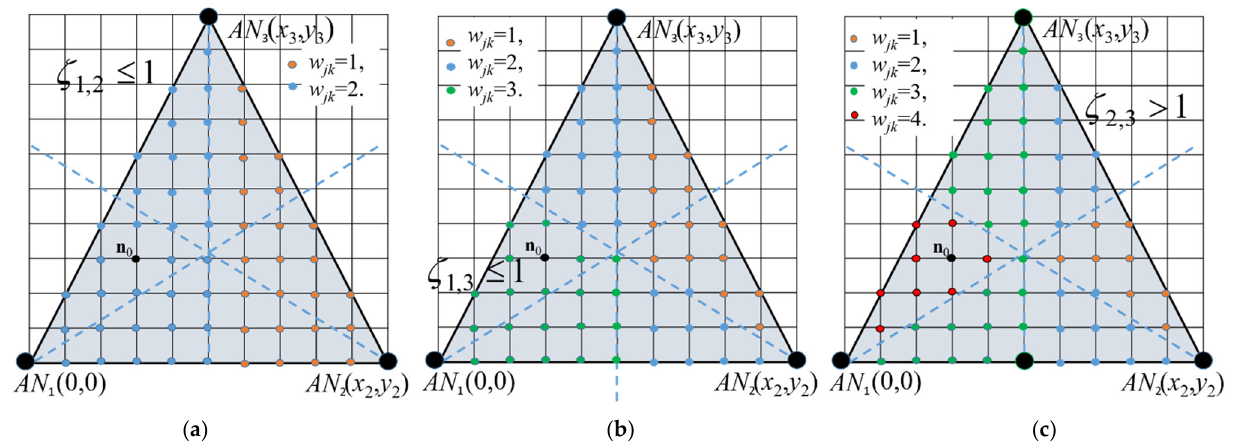
Figure 2. Weight assignment distribution for tree ANs and for relations ( a ) ζ 1,2 ≤ 1, ( b ) ζ 1,3 ≤ 1, and ( c ) ζ 2,3 > 1.